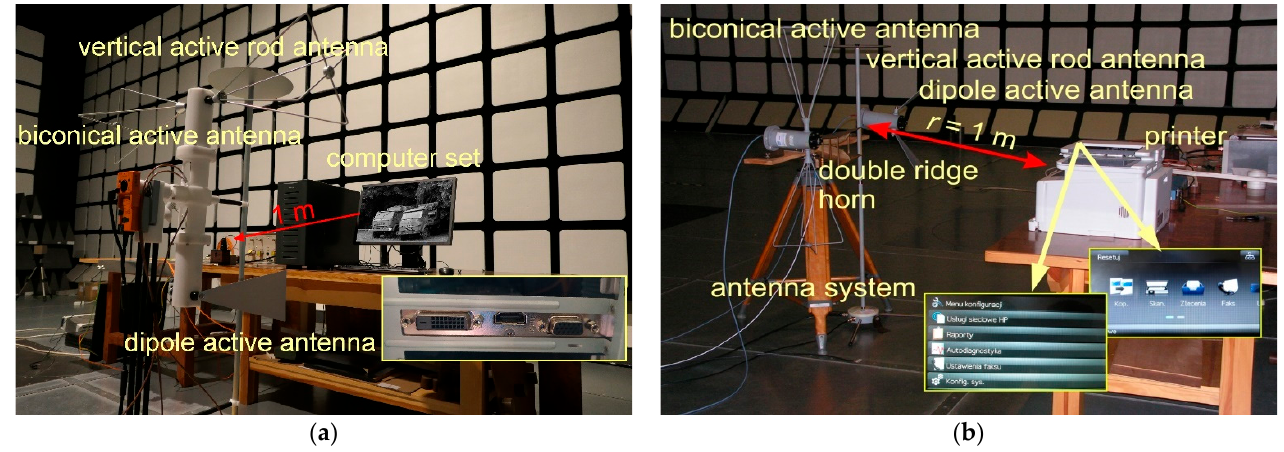
Figure 8. Measuring systems for three different sources of revealing emissions: ( a ) HDMI and DVI standards, ( b ) display of laser printers.